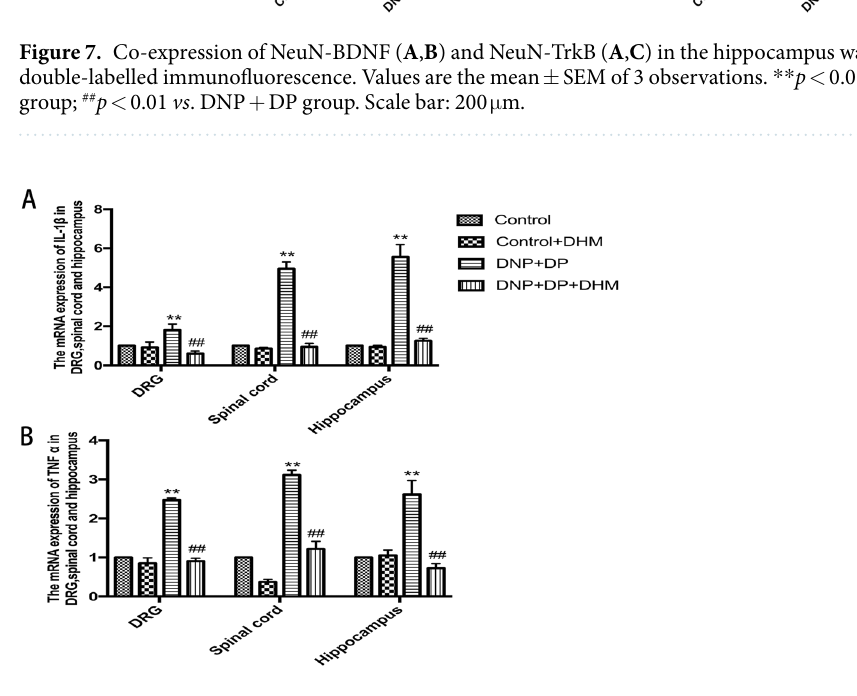
Figure 8. Effects of DHM on the expression levels of IL-1 β ( A ) and TNF- α ( B ) mRNA in the DRG, spinal cord and hippocampus of rats with comorbid DNP and DP as detected by qRT-PCR. Values are the mean ± SEM of 6 observations. * p < 0.05 and ** p < 0.01 vs . control group; ## p < 0.01 vs . DNP + DP